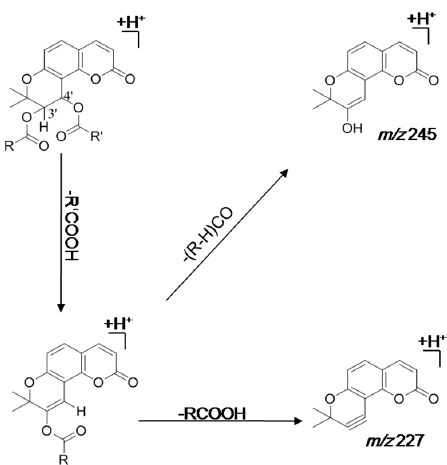
Figure 2. Proposed cracking rules of khellactone derivatives using electrospray ionization-tandem mass spectrometry.